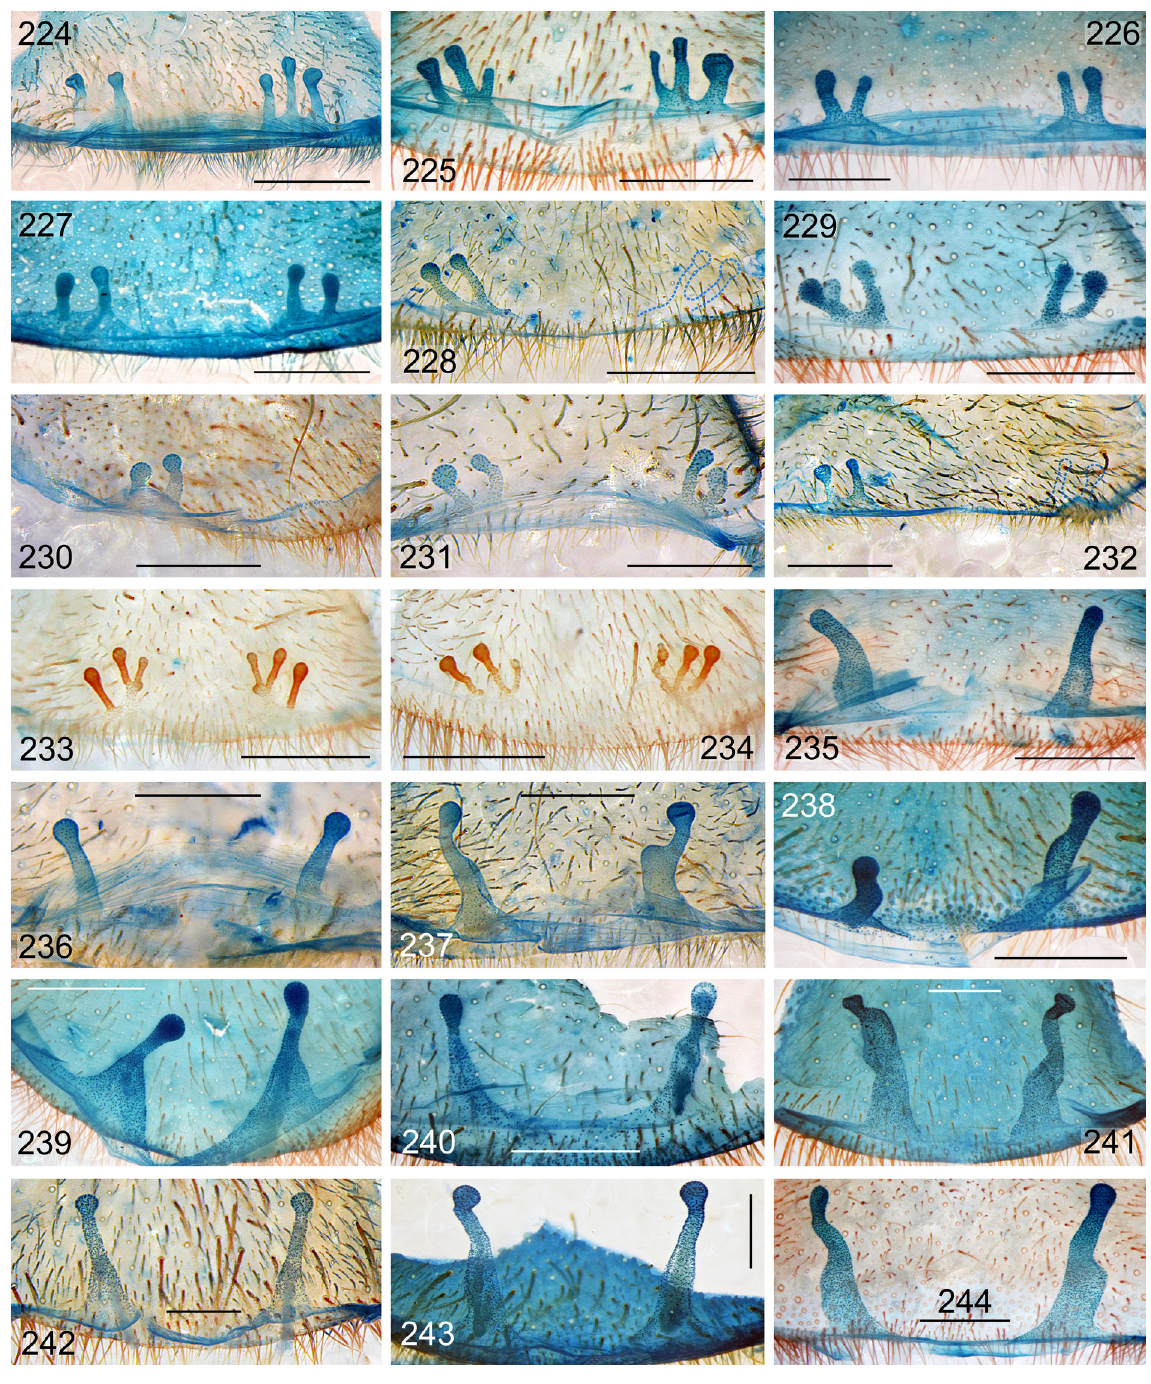
Figs 224–244. Anemesia spp., ♀♀, spermathecae, dorsal views. 224 . A. birulai (Spassky, 1937) (Kepele). 225 . Same (Zulfagar Mts). 226–227 . Same (Kushka). 228-229 . A. pococki sp. nov. (paratypes). 230 . A. tubifex (Pocock, 1889) (Kalaimor). 231 . Same (Zulfagar Mts). 232 . Same (Gyangaly). 233– 234 . A. andreevae sp. nov. (paratypes from Babatag Mts and Varzob, respectively). 235 . A. sogdiana sp. nov. (Varzob). 236 . Same (paratype, Amankutan). 237–238 . Same (Akrabat). 239–240 . Same (Kugitang Mts: Badlydara and Vandob, respectively). 241–242 . A. oxiana sp. nov. (paratypes, Ganjina). 243–244 . Same (paratypes, Sanglok Mts and Mt Astana, respectively). Scale bars: